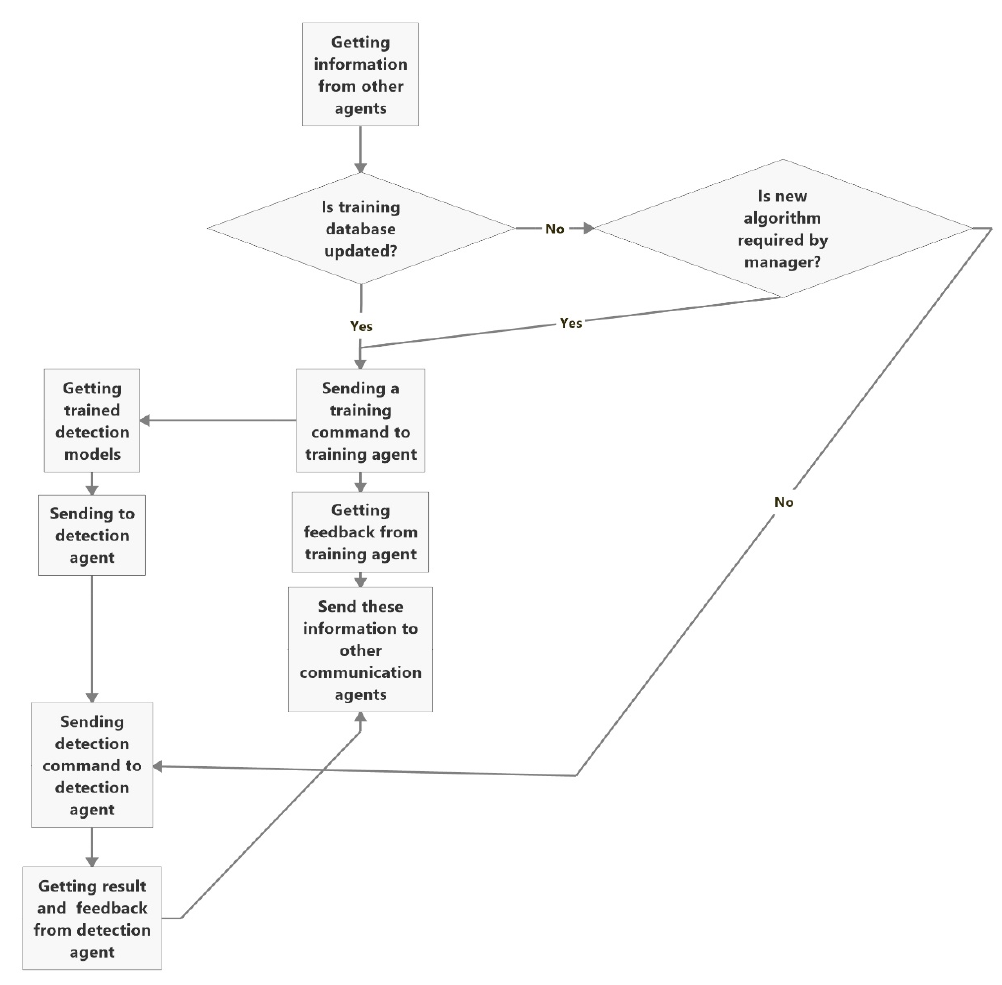
Figure 3. Process for detection and analysis.